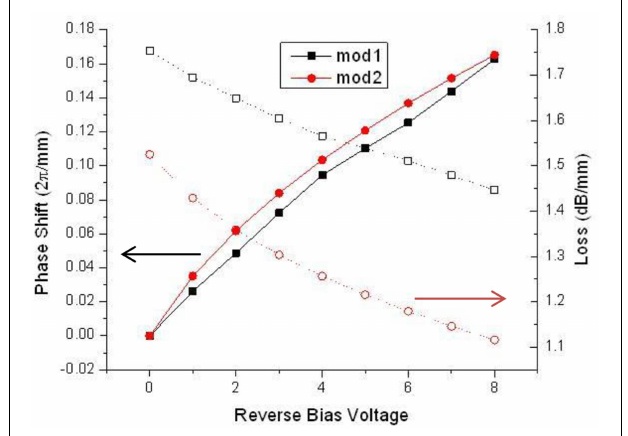
FIGURE 5 | Phase shift efficiencies and loss for mod1 and mod2.